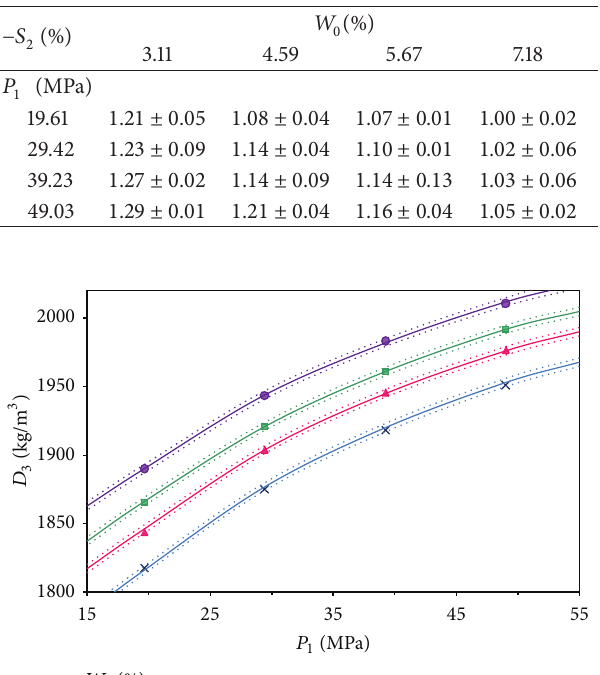
Table 4: Experimental values of springback ( 𝑆 2 ) as a function of the powder moisture content ( 𝑊 0 ) and compaction pressure ( 𝑃 1 ) with the data interval error at 95% confidence level.